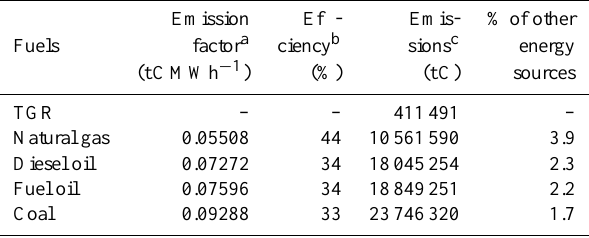
Table 2. GHG emissions by thermal power plants assuming the gen- erating power output equivalent to that of the Three Gorges power station in